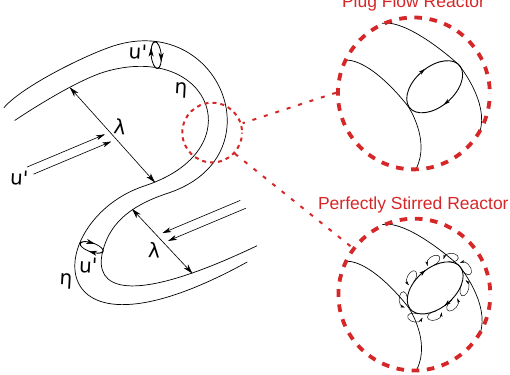
Figure 5. Schematic view of the different fine structure treatments, adapted from [31]. indicates the fine structures, while indicates the mass transfer between them and the